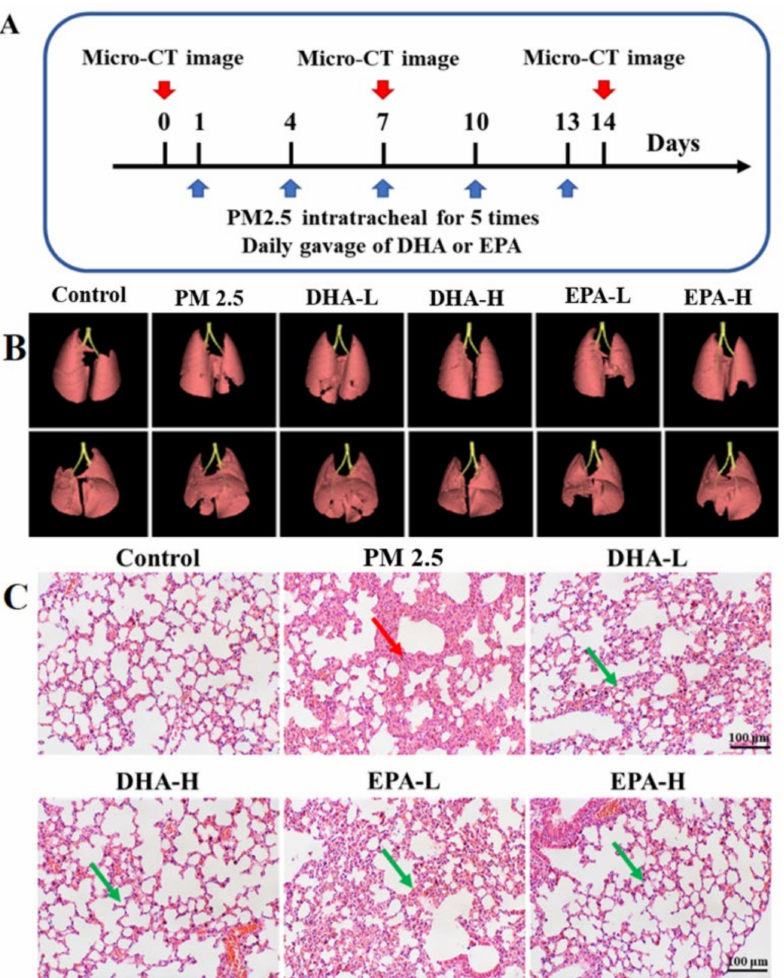
Figure 3. DHA and EPA attenuated PM2.5-induced lung injury in mice. ( A ) Intratracheal adminis- tration of PM2.5 for 5 times (blue arrows). Daily gavage of EPA or DHA for 14 consecutive days. ( B ) Micro-CT three-dimensional reconstruction of lung tissue from mice exposed to PM2.5, and treated with DHA and EPA for 14 days, respectively. The mice in the control group were orally administered with saline. ( C ) Histological examination of the lung on day 14 of PM2.5 exposure. The red arrow indicated the alveolar wall’s remarkable thickening, and the green arrow showed the usual